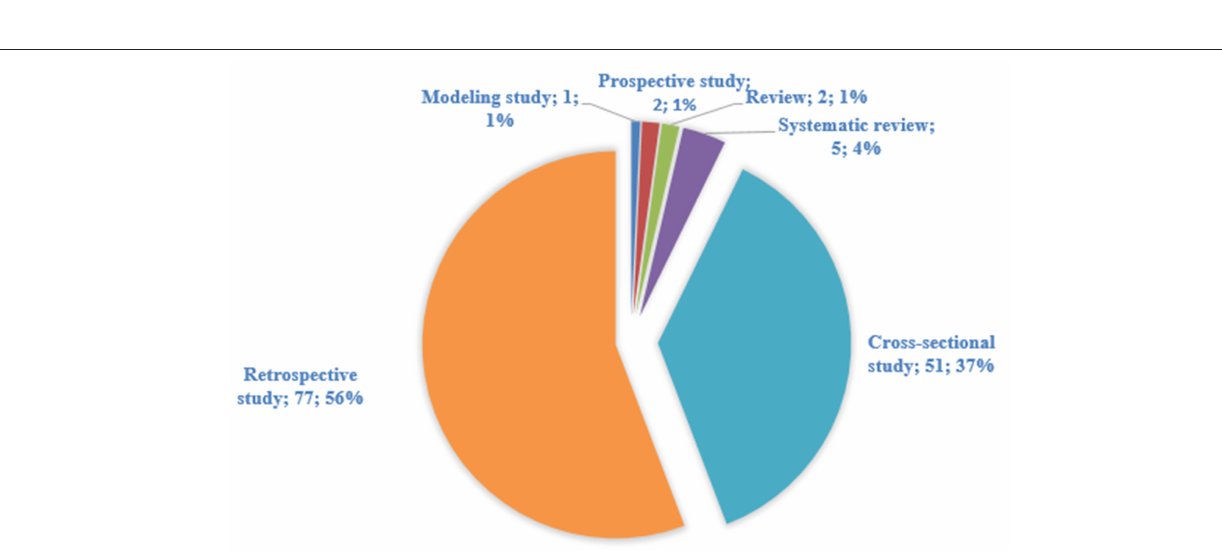
Frontiers in Public Health | www.frontiersin.org 4 June 2022 | Volume 10 | Article